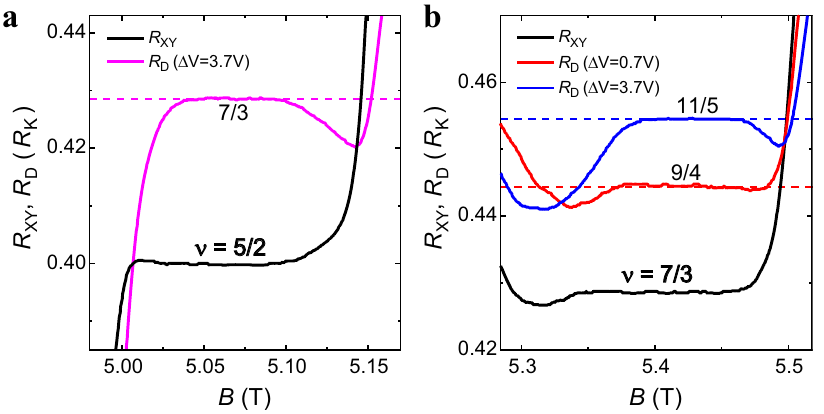
Fig. 4 | Anomalous plateaus at v =5/2 and v =7/3 with different gate voltages. Black traces represent R XY and traces in other colors represent R D at different gating conditions. All the plateaus are consistent with predicted values in Fig. 3c.